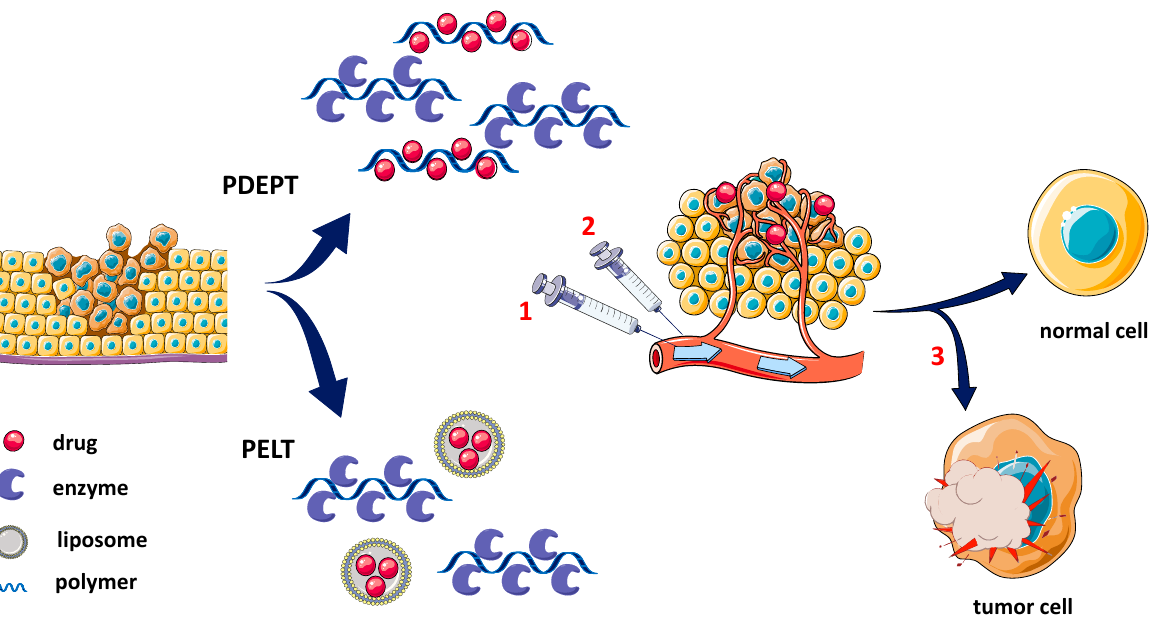
Figure 1. Stages in PDEPT and PELT strategies: 1—administration of polymer–drug/lipid–drug conjugate; 2—administration of polymer–enzyme conjugate; 3—intratumoral drug release. Adapted from [22], Elsevier, 2017.